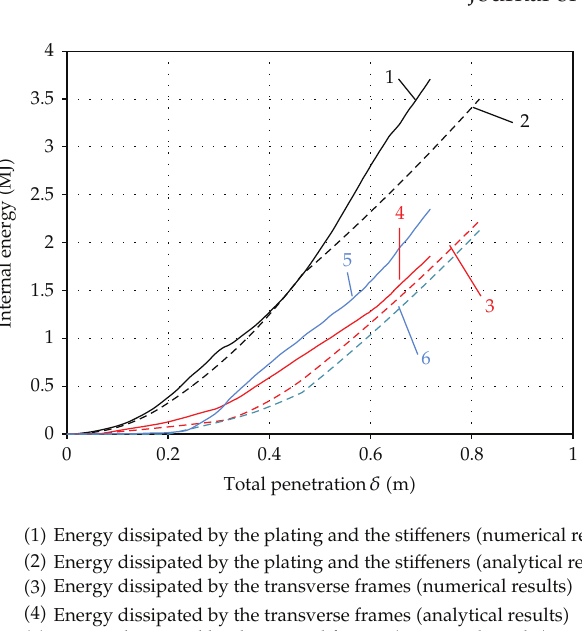
Figure 34: Comparison of the analytical and numerical internal energy of the various components of the